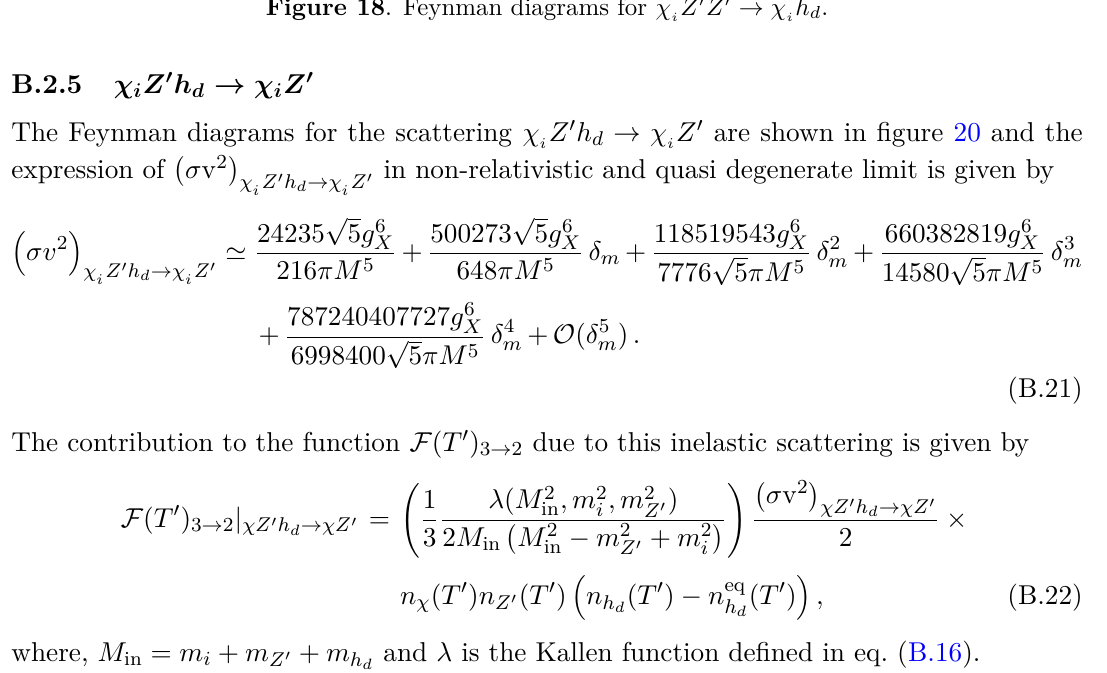
Figure 18 . Feynman diagrams for χ